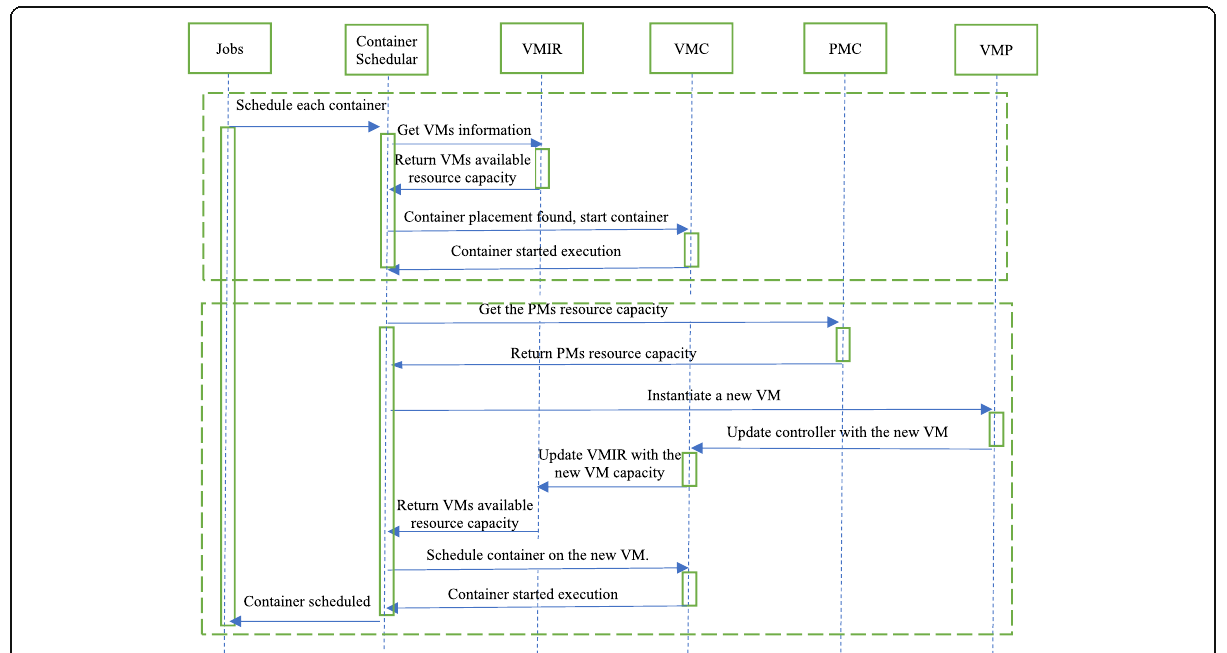
Fig. 4 Sequence diagram for scheduling a container in the proposed